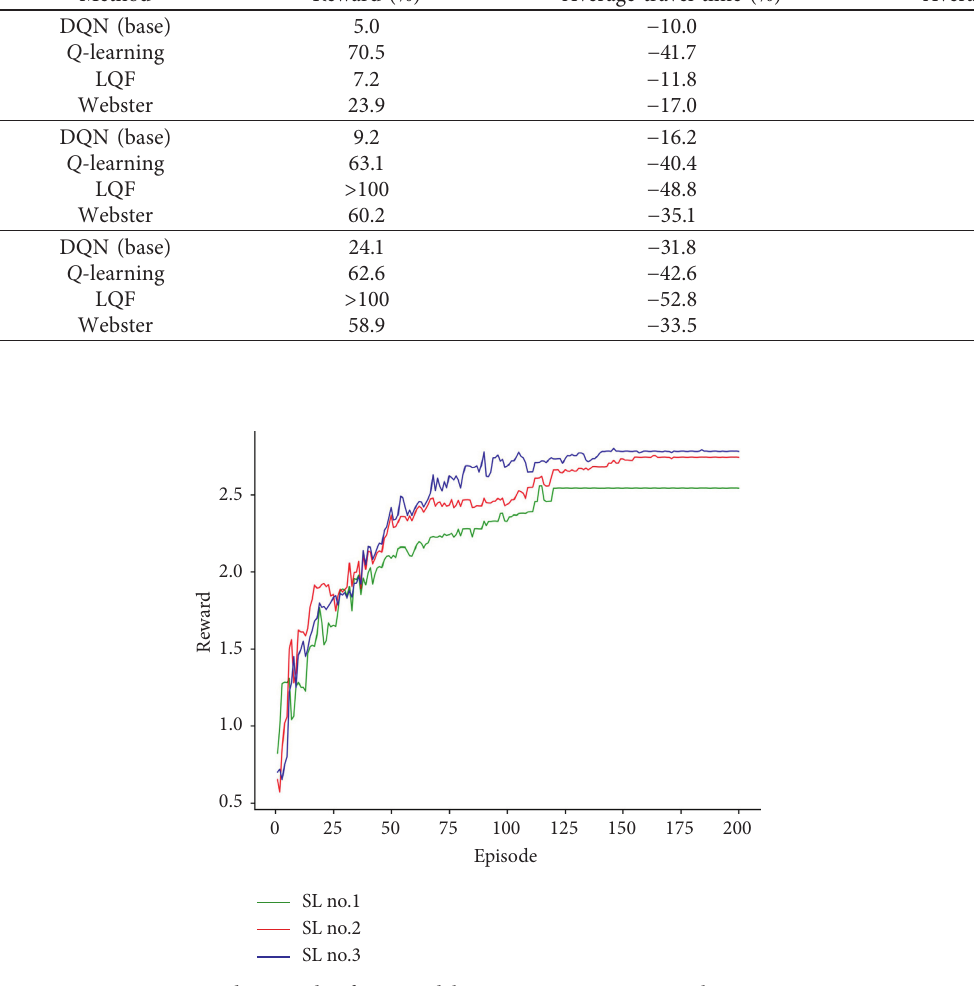
Figure 11: Episode rewards of our model in training process in multi-intersection